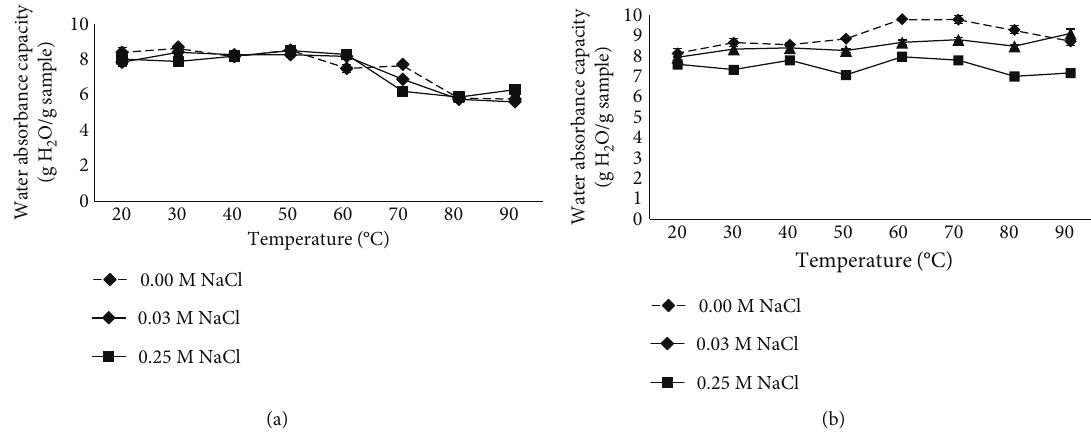
Figure 4: In fl uence of temperature and NaCl concentrations on water absorption capacity of deproteinized ethanol-treated sun fl ower meal at pH 6 (a) and pH7